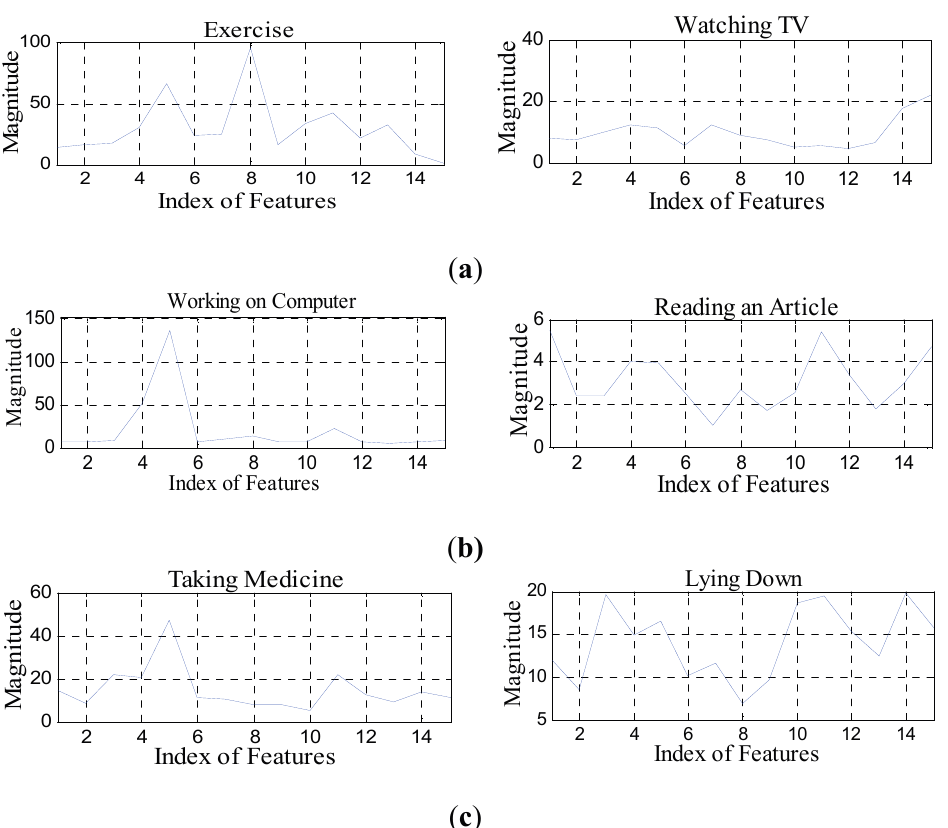
Figure 5. Magnitude features from the joint points of the body parts of human activities under the indoor environments. ( a ) smart home activities, ( b ) smart office activities and ( c ) smart hospital